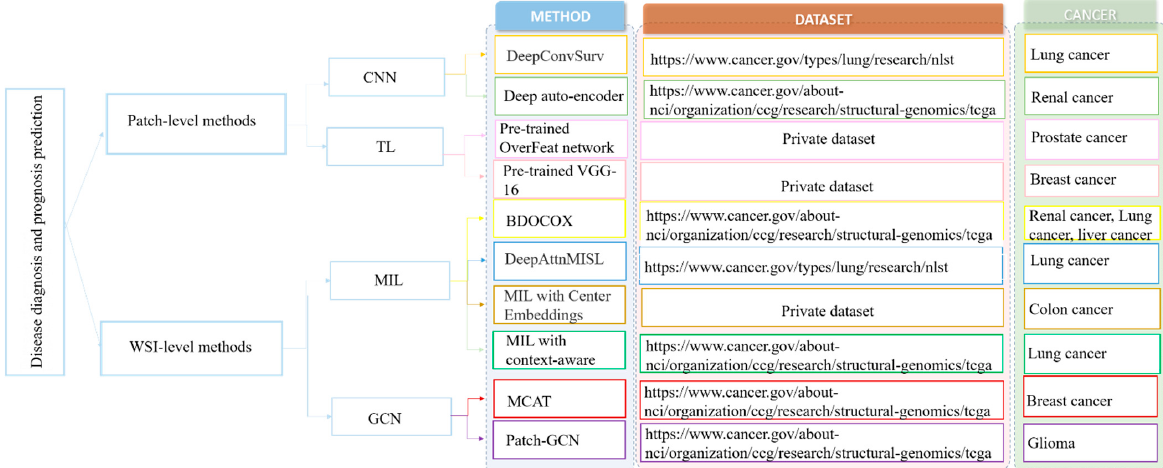
Figure 7. Overview of papers using deep learning for diagnosis and prognosis of the disease in histopathology images [108–116].